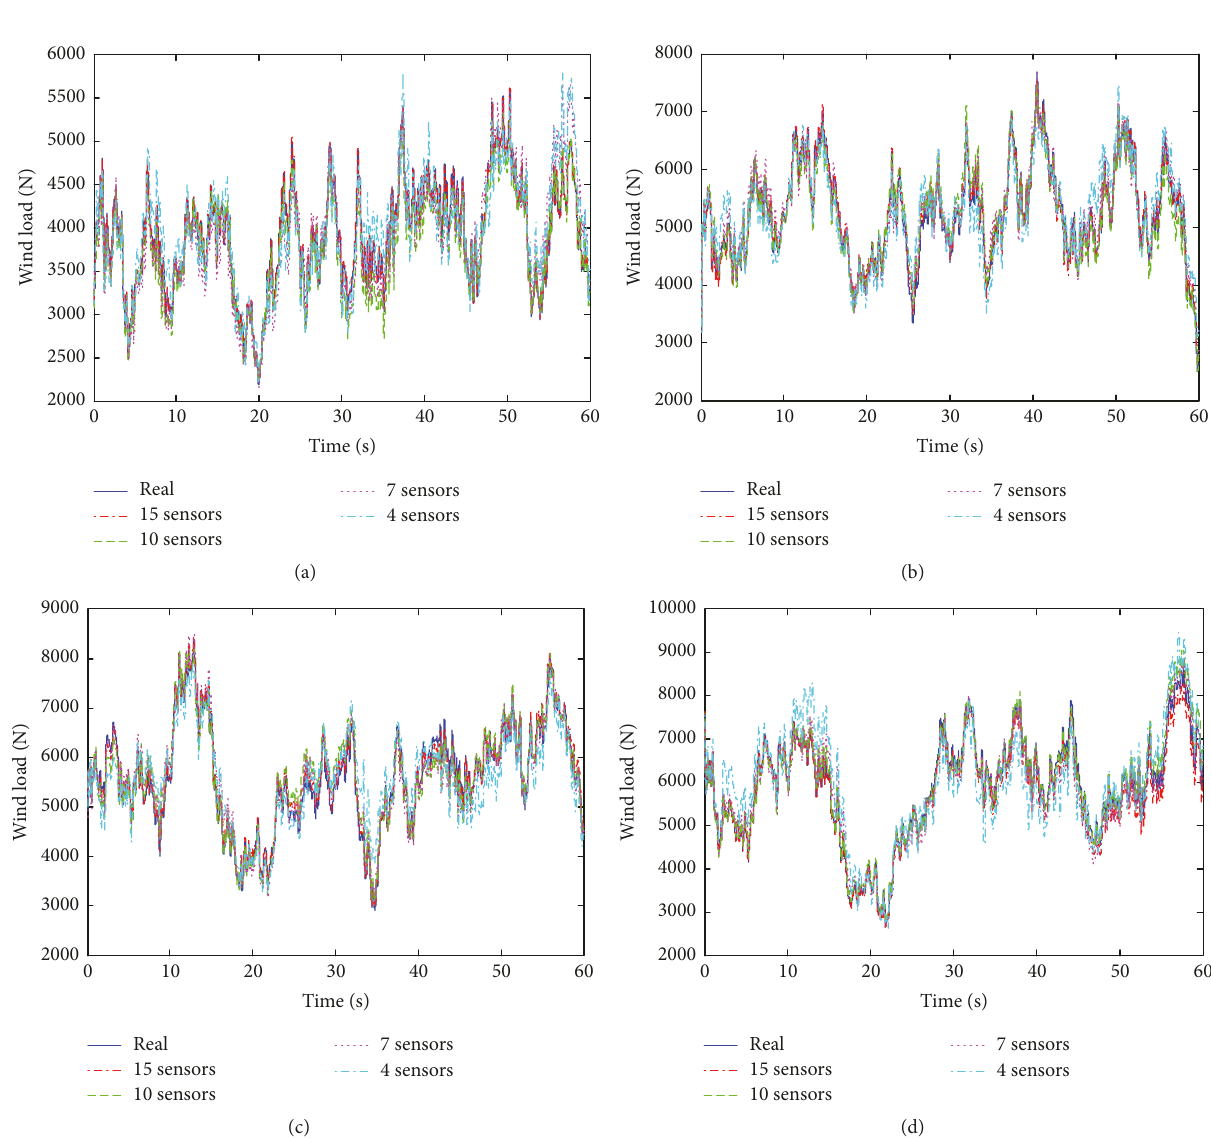
Figure 6: The time histories of the estimated wind load for different numbers of sensors. (a) On the 5th floor; (b) on the 10th floor; (c) on the 15th floor; (d) on the 20th